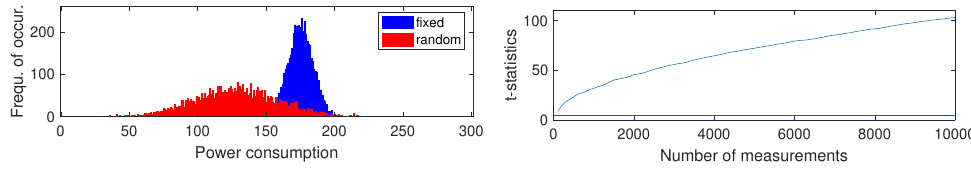
Figure 10: Histograms of the fixed and random groups and development of the maximum t -value over the number of traces for the static power